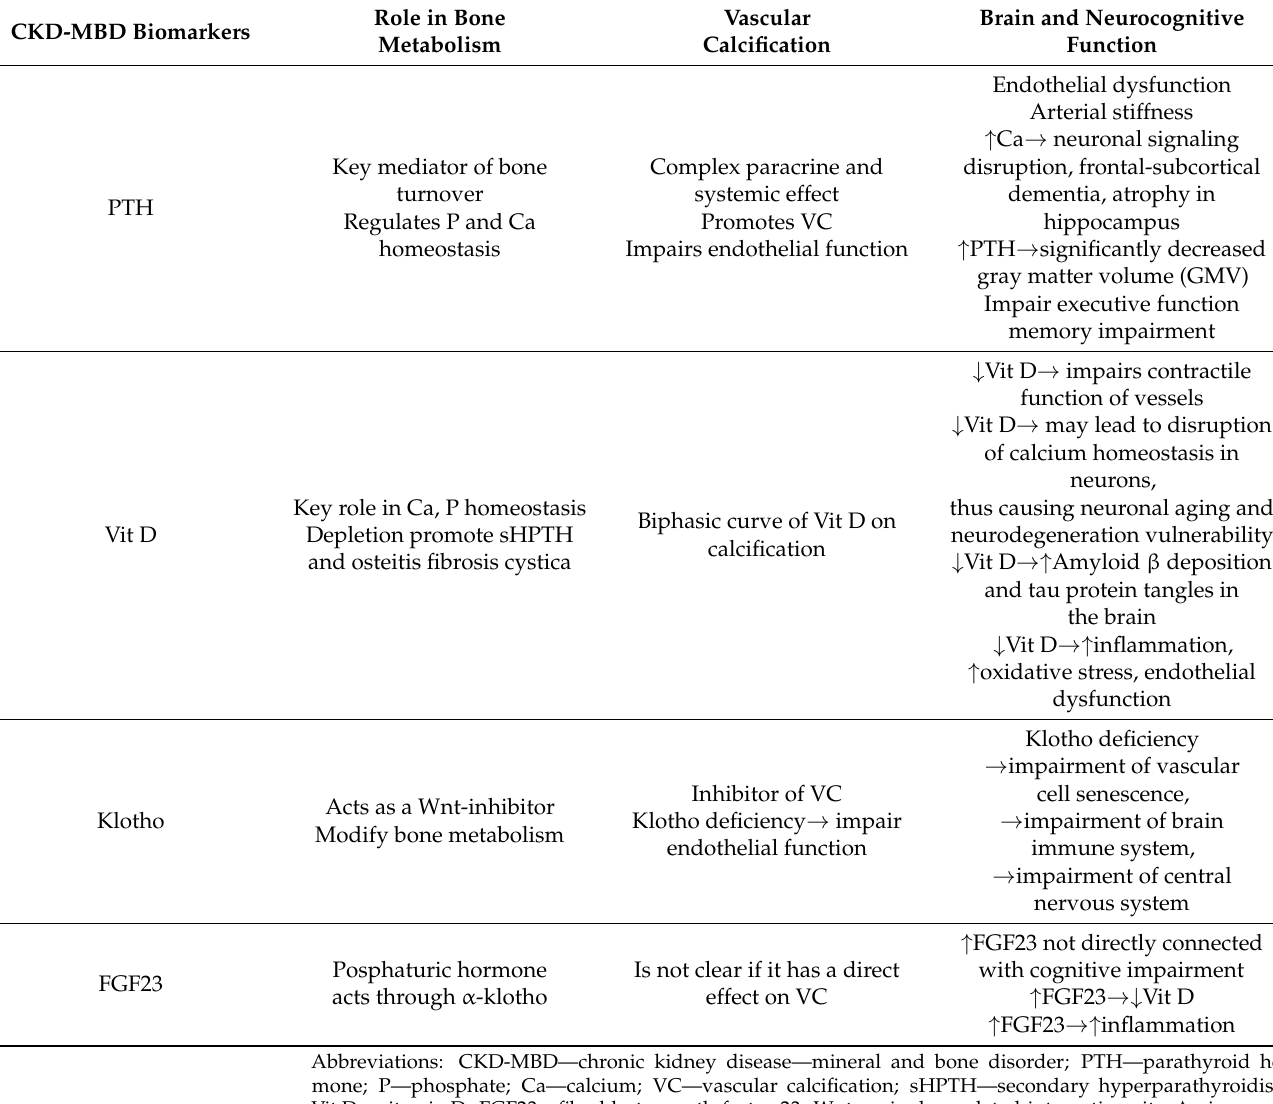
Table 1. CKD–MBD biomarkers, role in bone metabolism, vascular calcification, brain, and neurocog- nitive